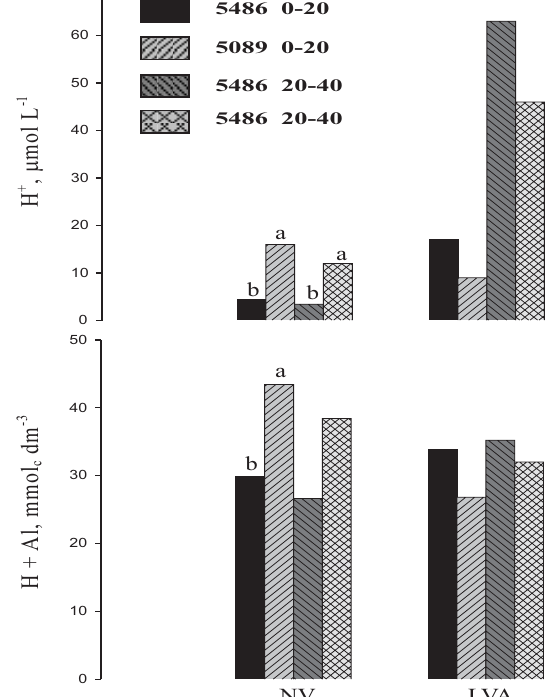
NV LVA Figura 2. Concentração de íons H + e acidez potencial (H + Al) em duas profundidades dos solos NV e LVA com os cultivares de cana-de-açúcar RB83- 5089 e RB83-5486 (amostras coletadas no final da safra 2001/2002). Letras diferentes dentro de cada profundidade indicam que médias diferem entre si pelo teste de Tukey a 5 %.